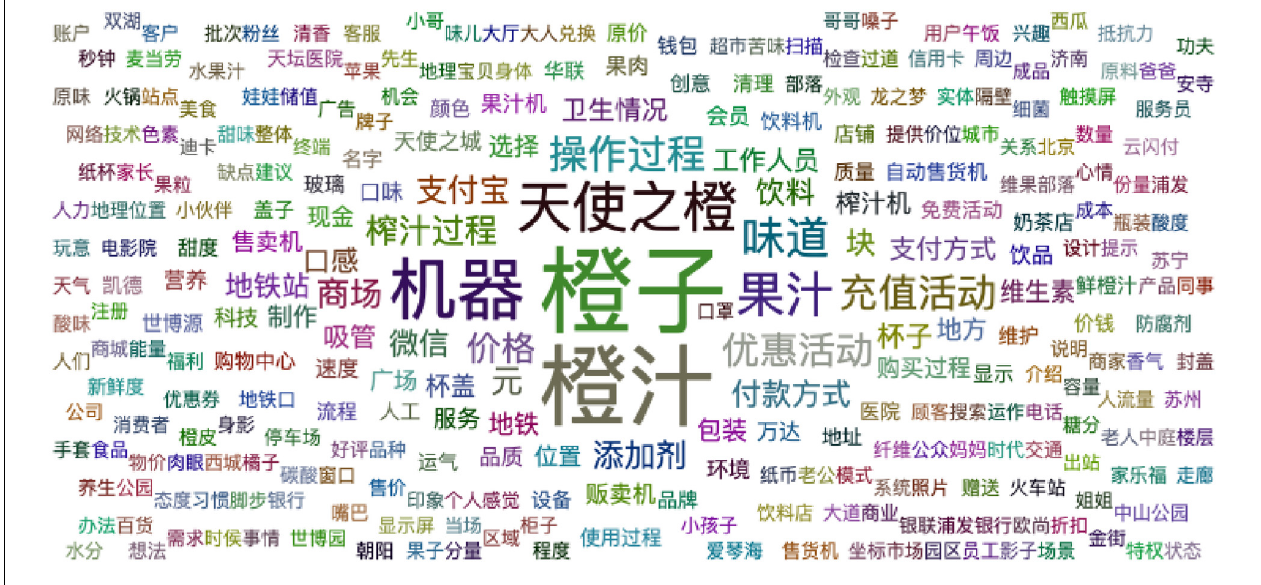
FIGURE 3 | Noun cloud figure of “Angel Orange” unmanned retail